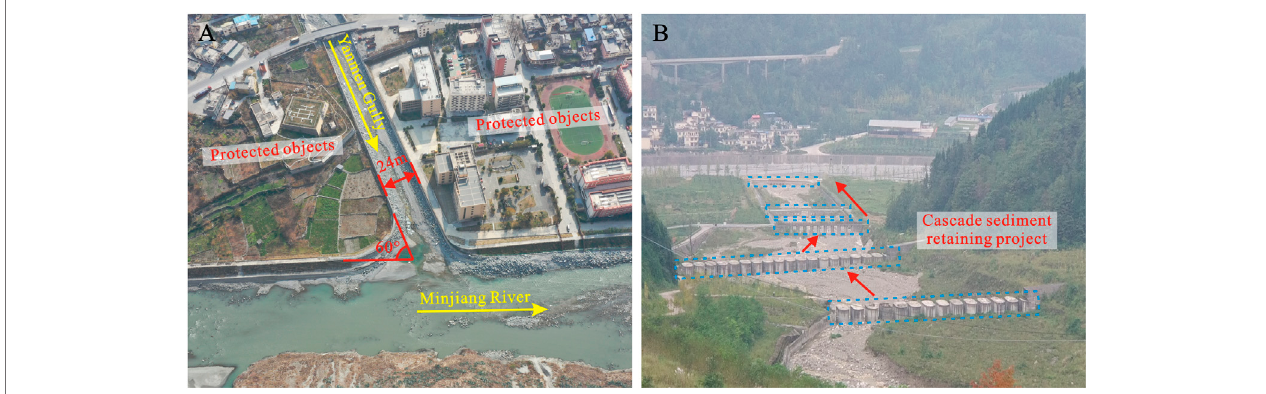
FIGURE11| Typicalcasesofdisasterpreventionandcontrolmeasuresandachievementsinrecentyears: (A) adrainagechannelbuiltinYanmenGully,Wenchuan County, Sichuan Province; and (B) the cascade sediment retaining project built in Qingping Township, Mianzhu City, Sichuan Province.